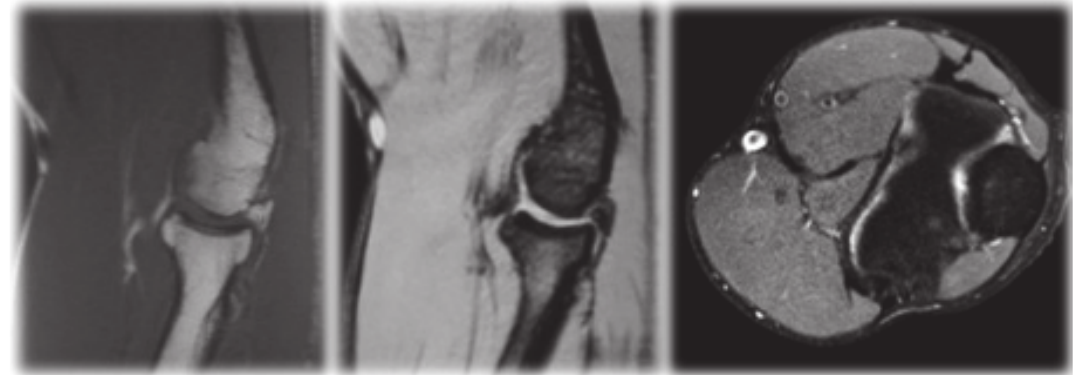
Figure 4: MRI of patients right elbow at one-year follow-up, demonstrating full recovery of the previously described lesions.